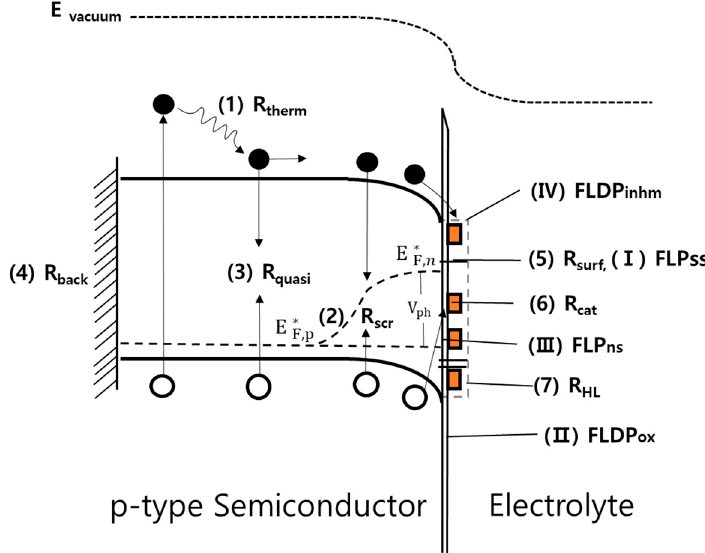
Figure 16. Basic recombination factors in PEC cells under illumination and the related effects. (1) R thermo is the thermalization loss of the excited electron, (2) R scr is the recombination of the space charge region (SCR) (depletion layer) at the surface, (3) R quasi is the recombination at the quasi-neutral region of the semiconductor, (4) R back is the back Ohmic contact recombination, (5) R surf is the surface recombination induced from the surface states of Si. (6) R cat is the recombination occur within the MoS 2 film. (7) R HL is Helmholtz layer recombination in the electrolyte. (I) FLP ss is the Fermi-level pinning induced from the surface states, (II) FLDP ox is the Fermi-level depinning due to the oxide (typically native oxide), (III) FLP ns is the Fermi-level pinning induced from the nano Schottky junctions, (IV) FLDP inhm is the Fermi-level depinning results from the inhomogeneous Schottky junctions.